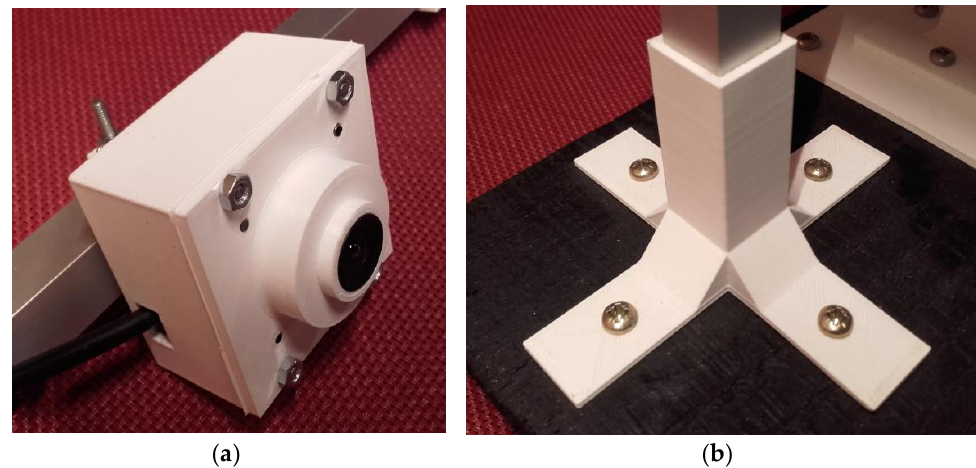
Figure 10. Printed BPS system parts: ( a ) USB camera housing; ( b ) USB camera tube slippers.